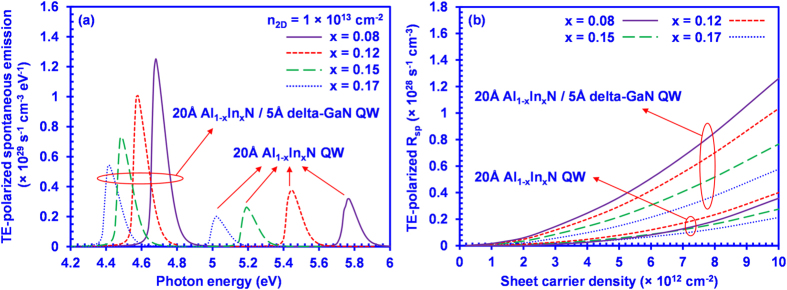
(a) TE-polarized spontaneous emission spectra as a function of photon energy at sheet carrier density of 1 × 1013 cm−2 at T = 300 K and (b) TE-polarized spontaneous emission rate per unit volume as a function of sheet carrier density from 2.5 × 1011 cm−2 to 1 × 1013 cm−2, for 20 Å Al1–xInxN/5 Å delta-GaN QW and 20 Å Al1–xInxN QW.